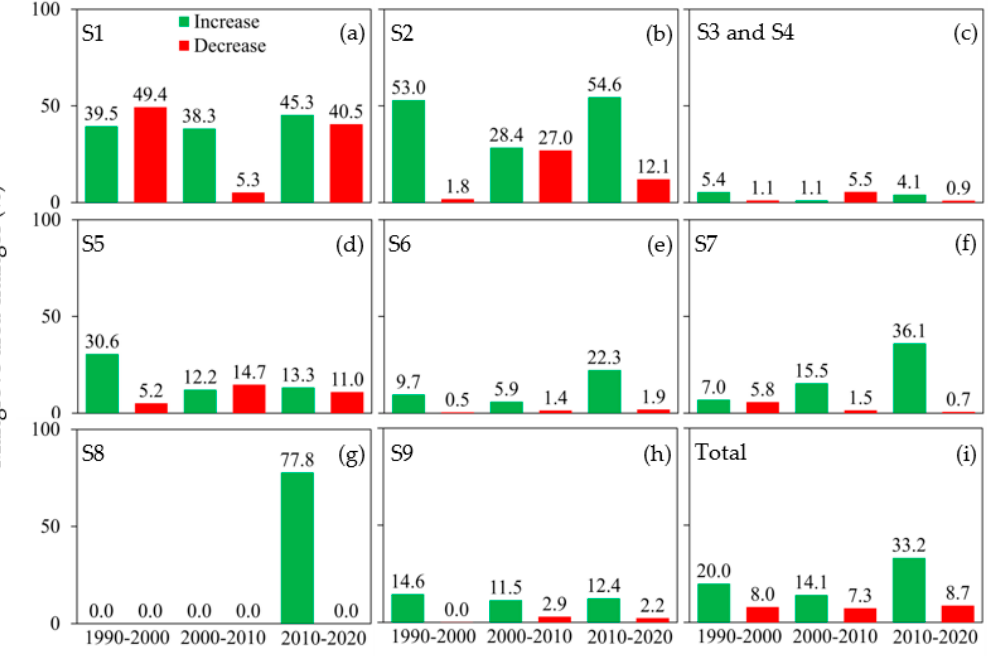
Figure 6. Mangrove area increase and decrease over time (three decades of 1990 – 2000, 2000 – 2010, and 2010 – 2020 epochs) in all major mangrove sites (S1 – S9 in Figure 1) on SMRI images. Panels ( a – h ) show changes of mangroves in each study site, and panel ( i ) exhibits the total changes in all sites. The total spatiotemporal changes of mangrove forests within the study sites in the temporal interval between 1990 and 2020 are presented in Figure 7. The visual interpretation of spatial changes of mangroves revealed that their expansions were landward in some study sites (S6, S7), although their development was seaward in S5 and S9. The mangrove losses mostly occurred landward, which are well shown in two subsites of S5.